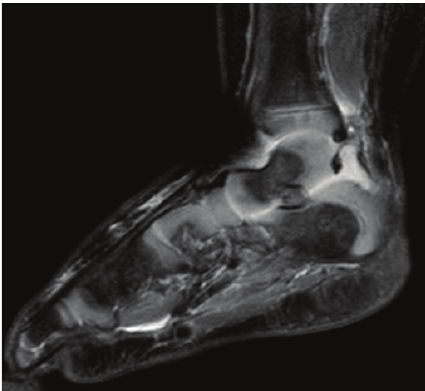
Figure 2: MRI of right ankle reveals hyperintense fluid in the tibiotalar and the subtalar joint with no signs of